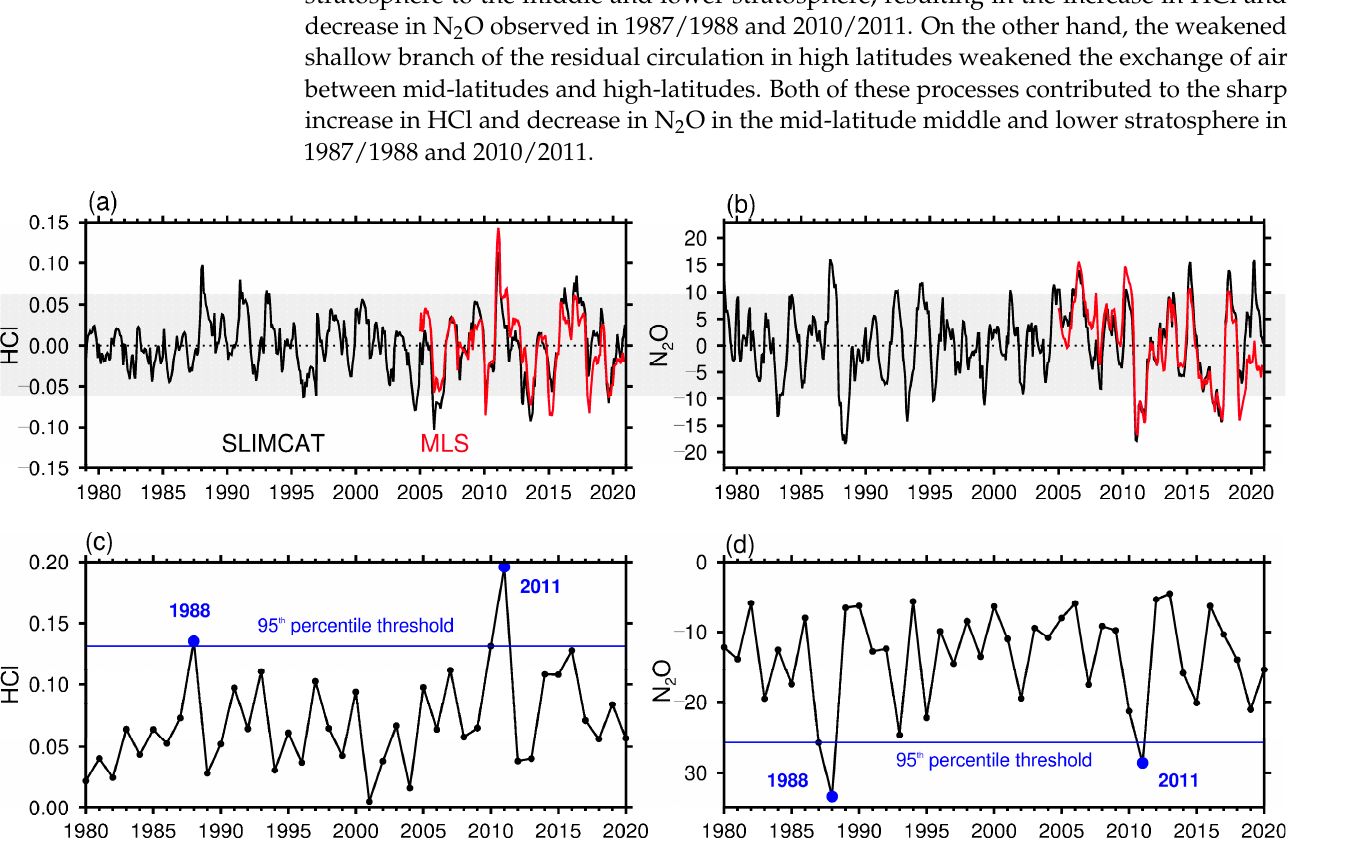
Figure 1. ( a , b ) Variation in ( a ) HCl and ( b ) N 2 O anomalies in the NH mid ‐ latitude middle and lower stratosphere (20–50 o N, 10–50 hPa) from 2005 to 2020 based on MLS data (red line). The linear trends of HCl and N 2 O were removed. The black line is based on the SLIMCAT model simulation for the period of 1979 to 2020, and the trend for HCl was removed by splitting the time period (1979–1997, 1997–2021), due to the effectiveness of the Montreal Protocol. ( c , d ) Variation in ( c ) HCl and ( d ) N 2 O gradient from 1980 to 2020 based on SLIMCAT model simulation. The HCl (N 2 O) gradient was calculated using the maximum value of HCl (minimum value of N 2 O) in a year minus the minimum (maximum) value in the past 12 months. The blue dots represent the years 1988 and 2011.